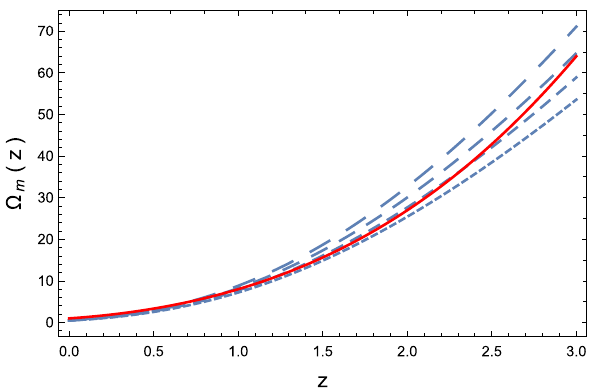
Fig. 1 Variation in the dimensionless Hubble function h as a function of the redshift z for η( z ) = a 1 h n ( z ) + b 1 for n = 2 / 3, b 1 = − 0 . 21, c 1 = 3 . 9, and different values of a 1 : a 1 = 0 . 348, (short dashed curve), a 1 = 0 . 350 (dashed curve), a 1 = 0 . 352, (long dashed curve), and a 1 = 0 . 354, (ultra-long dashed curve), respectively. The red solid line represents the prediction of the (cid:2) CDM model. The observational data are represented together with their error bars